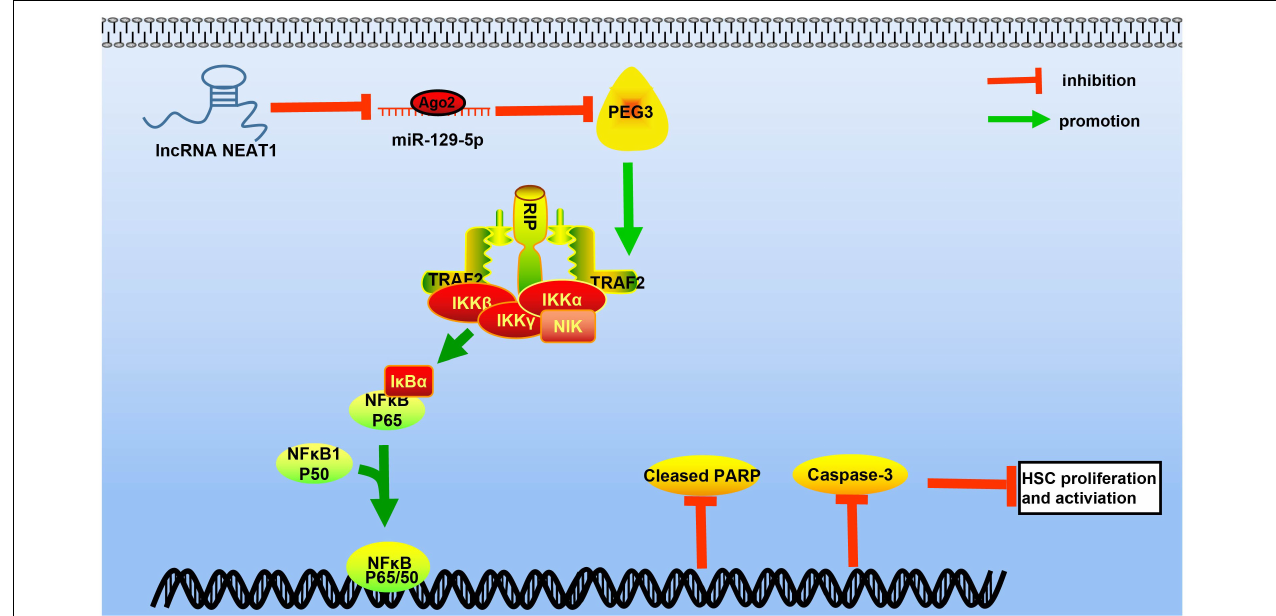
FIGURE 10 | Diagram depicting the molecular regulation mechanism of the NEAT1/miR-129-5p/PEG3 axis in liver fibrosis of mice with NASH through the NF- κ B signaling pathway. In mice with NASH, NEAT1, and PEG3 are highly expressed while miR-129-5p is poorly expressed. NEAT1 upregulates PEG3 expression by competitively binding to miR-129-5p to activate the NF- κ B signaling pathway, by which HSC apoptosis is inhibited and HSCs are activated to accelerate the process of liver fibrosis. N =